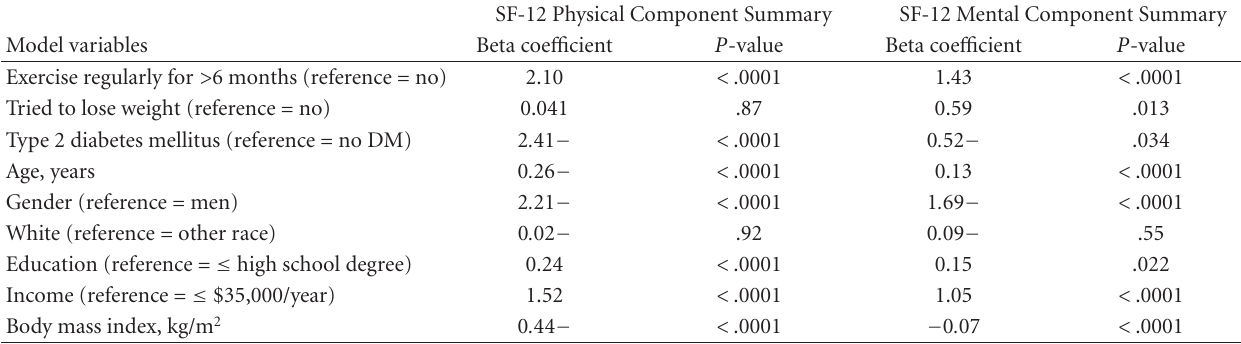
Table 4: Multivariate linear regression results for SF-12 physical and mental component summary